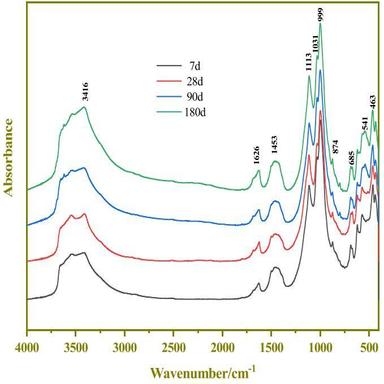
MIR spectra of sample RFG-5 after 7d, 28d, 90d and 180d curing.